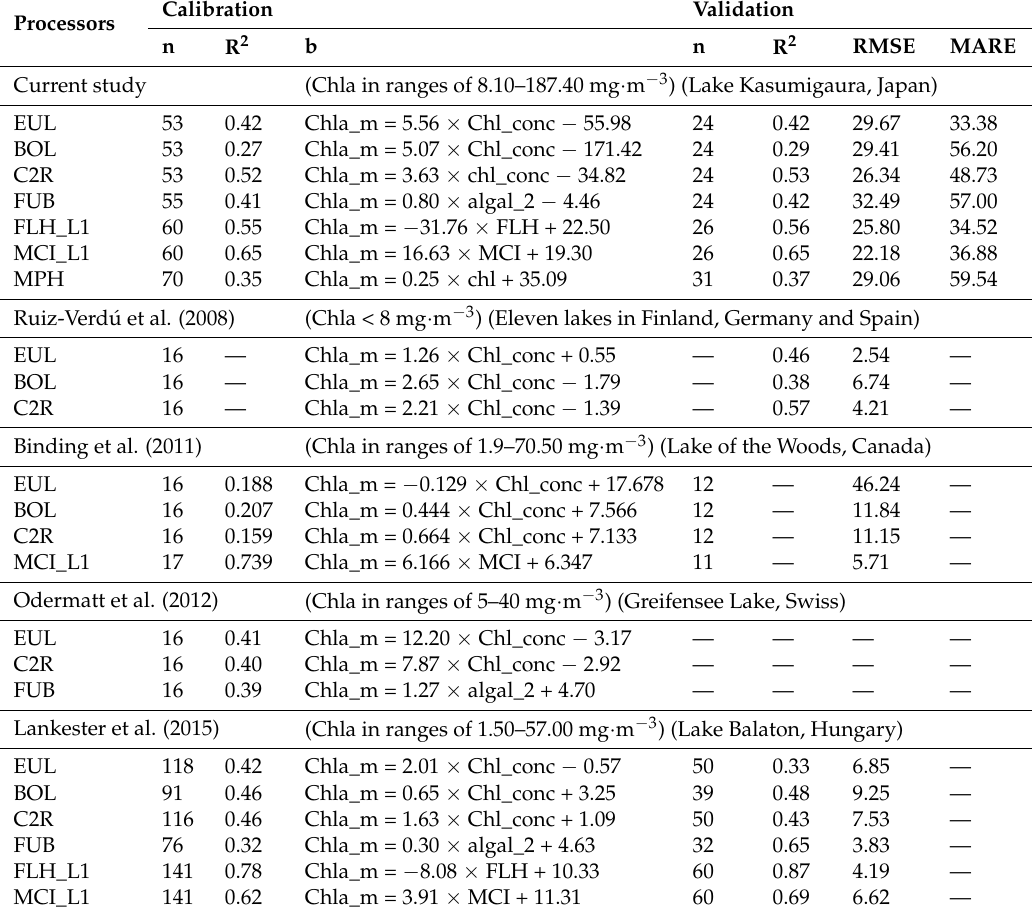
The text highlighted in bold represents the most accurate processor for each